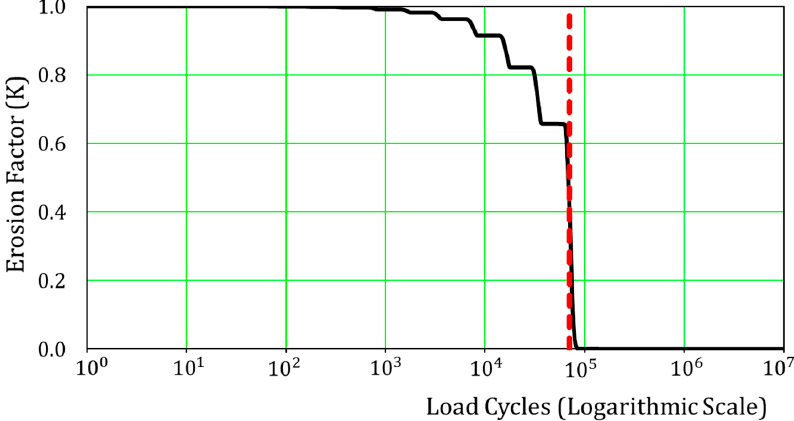
Figure 10. Load cycles and the erosion factor of the central zone of the RC deck.